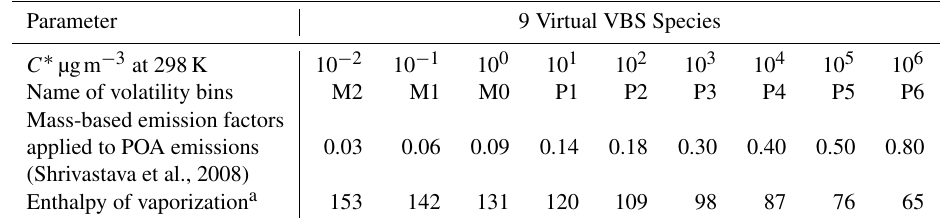
Table 1. Naming convention and parameters used in the VBS implementation described here. Parameter